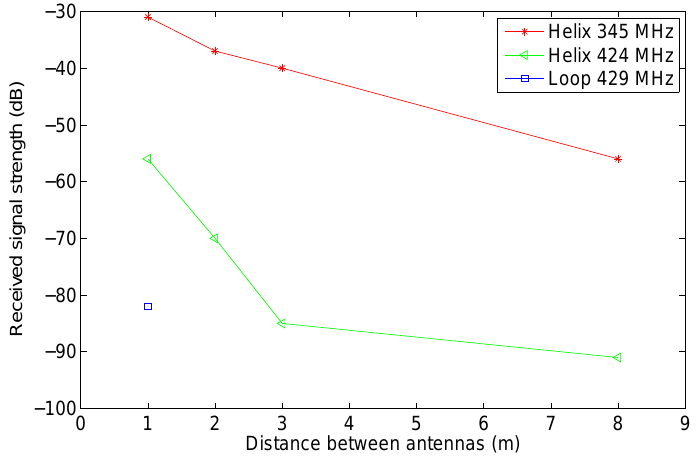
Figure 9. RSS of a loop and a helix antenna when embedded in silage. The transmission power of all signals were 5